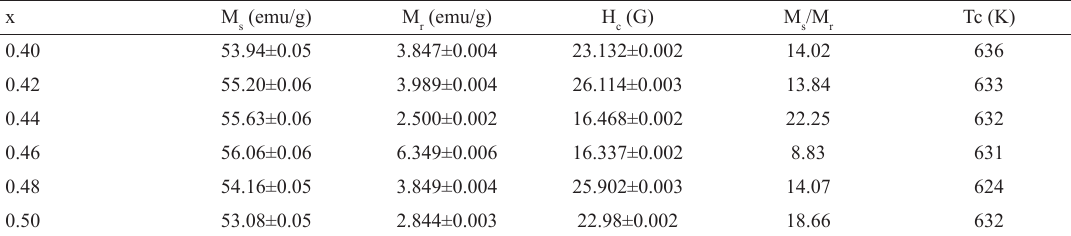
Cu Fe O x 1-x 2